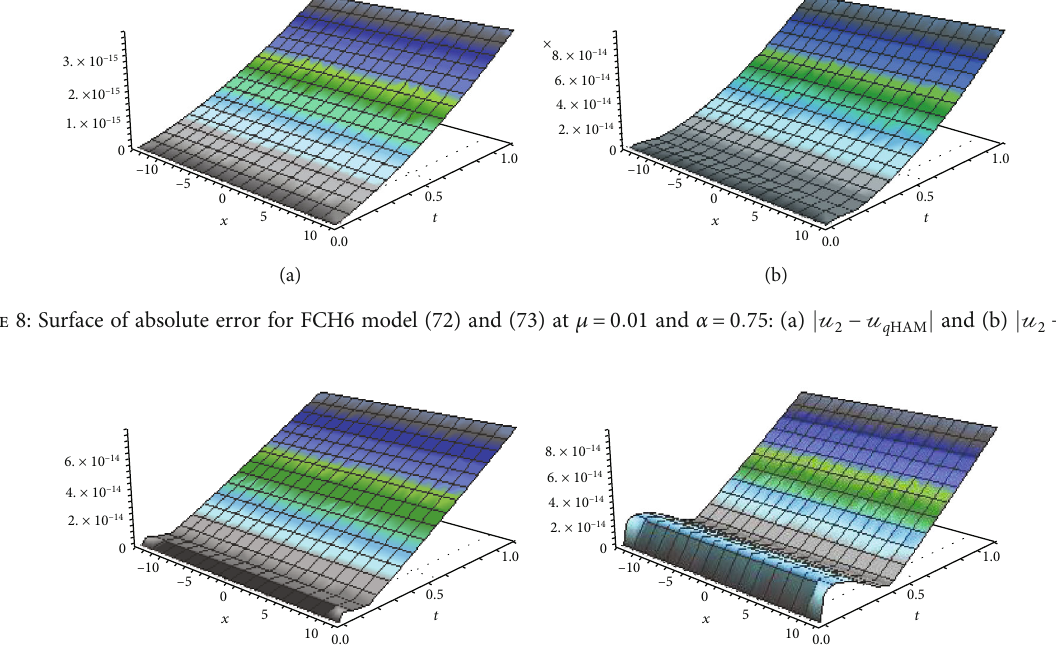
Figure 9: Surface of absolute error for FCH6 model (72) and (73) at μ = 0 : 01 and α = 0 : 5 : (a) j u